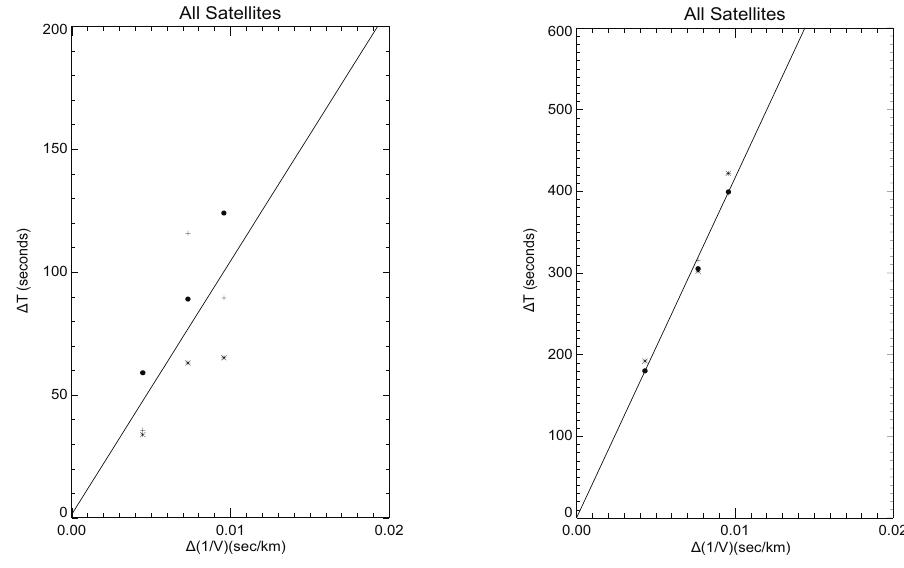
Fig. 8. Determination of the extension of the injection region. It is found to extent from ∼ 3deg (relative to dusk meridian toward midnight) to ∼ 13deg (relative to dawn meridian toward midnight), with proton and electron injection times at ∼ 04:09 UT and ∼ 04:16 UT, respectively. The left panel is for protons, while the right one is for electrons. Also, the plus, the asterisk and the dot signs denote LANL94, LANL97 and LANL91 spacecraft,